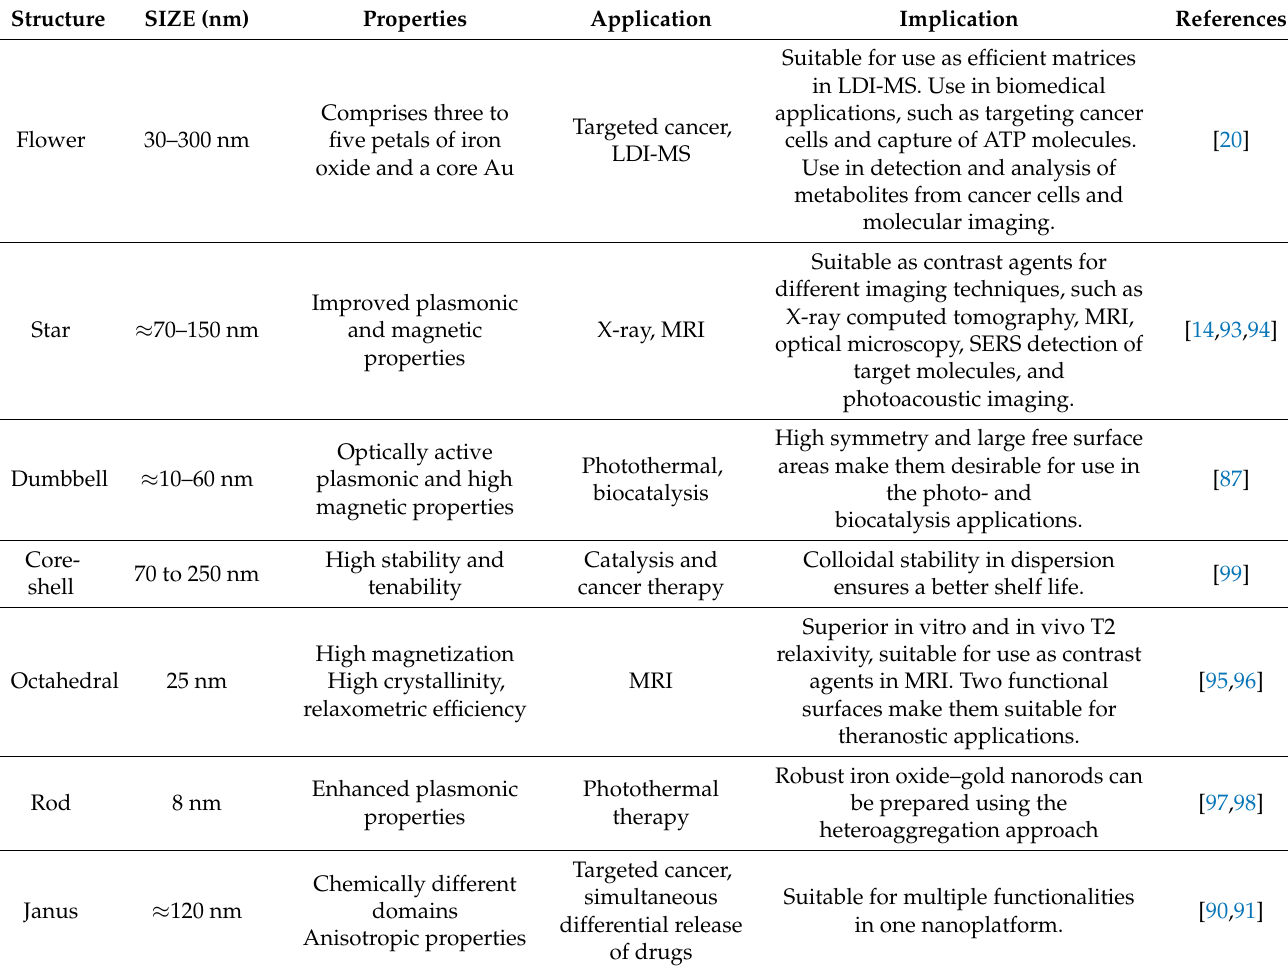
Table 2. Different structures of gold iron oxide nanoparticles, their properties and implications.